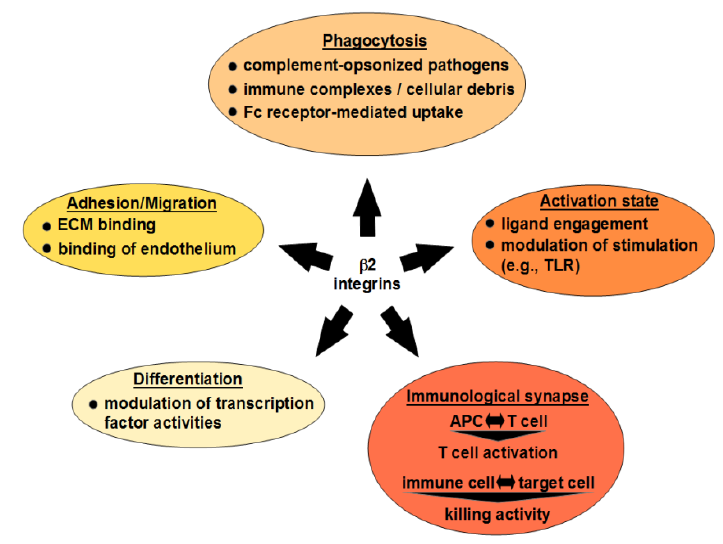
Figure 5. Schematic overview on the diverse functions of β 2 integrins.